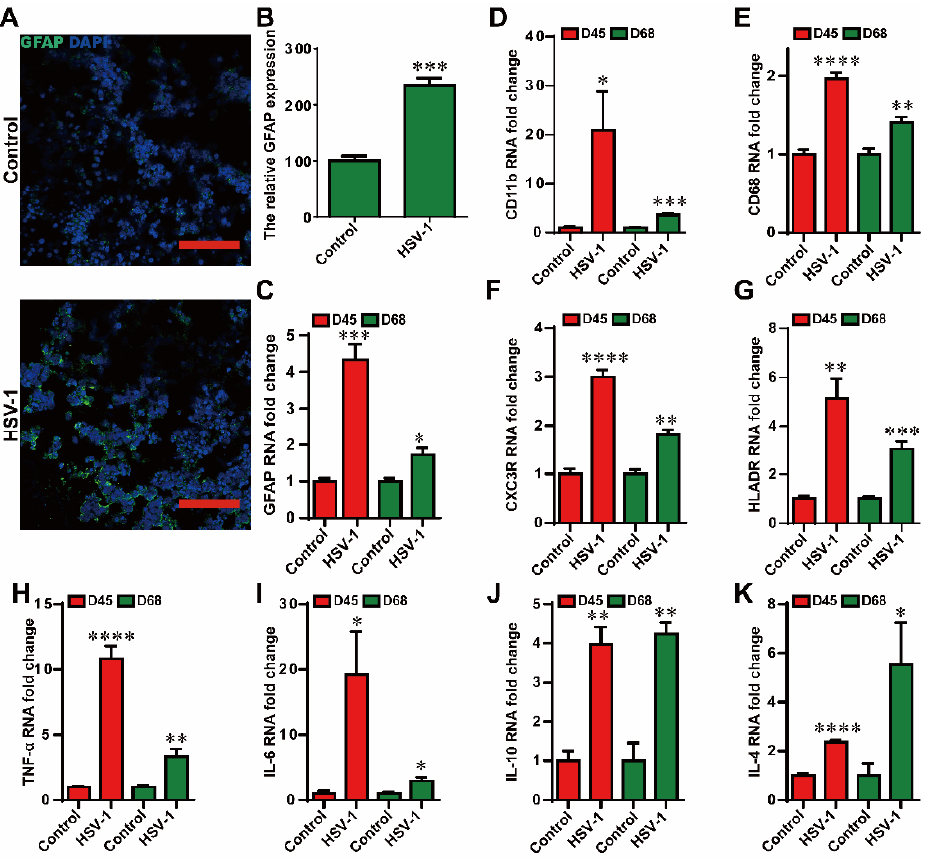
Figure 4. HSV-1 infection led to reactive gliosis and neuroinflammation in the cerebral organoids. ( A , B ) The expression of GFAP was identified by immunofluorescence staining, and the quantifi- cations for relative fluorescence intensity statistics of GFAP expressions were shown. Scale bars (red rectangle): 100 µ m. ( C ) The mRNA of GFAP was monitored by RT-PCR in the HSV-1 infected cerebral organoids at D42 + 3 and D65 + 3. ( D – G ) Validation by RT-PCR of microglia cells markers ( CD11b , CD68 , CX3CR , and HLADR ) in cerebral organoids at D42 + 3 and D65 + 3. ( H – K ) The mRNA expressions were examined for the inflammatory cytokines ( TNF- α , IL-6, IL-10, and IL-4 ) using RT-PCR in cerebral organoids in the different groups at D42 + 3 and D65 + 3. The expression value was normalized to the GAPDH expression level. Data represent the mean ± SEM. * p < 0.05 vs. the control group, ** p < 0.01 vs. the control group, *** p < 0.005 vs. the control group, **** p < 0.001 vs. the control group, ( n =